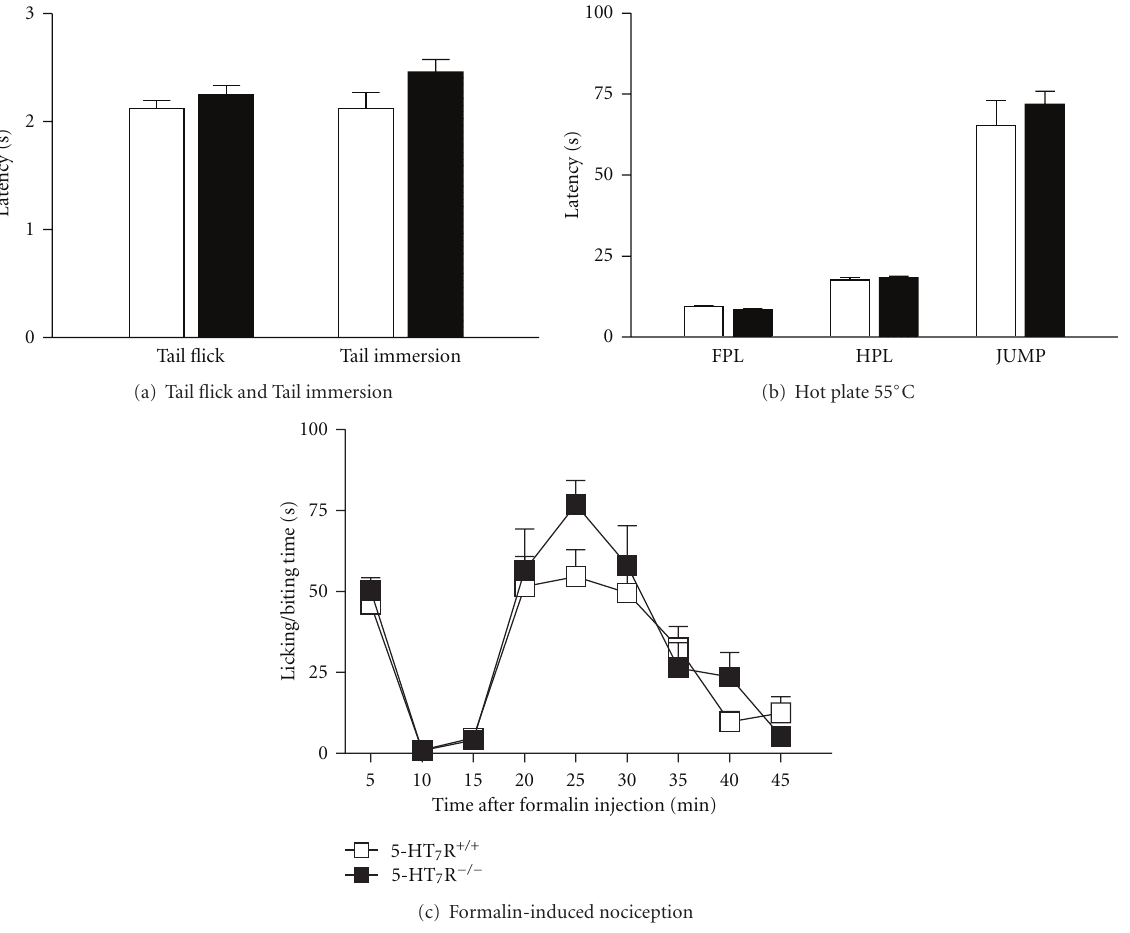
Figure 1: Nociceptive behavior of wild-type and 5-HT 7 receptor knockout mice in the tail flick and tail immersion tests (a), hot plate 55 ◦ C test (b), and formalin test (c). Both genotypes showed similar latency for all measured behaviors in the tail flick, tail immersion, and hot plate tests. Formalin-induced licking and biting of the hind paw injected with formalin in 5-HT 7 receptor knockout mice did not significantly di ff er from those in wild-type mice either in phase I (0–5 min) or in phase II (15–45 min). Only a slight but not significant increase of the licking/biting time was observed 25 min after formalin injection in 5-HT 7 receptor knockout mice compared to wild-type mice. Each bar or symbol represents the mean ± S.E.M. ( n = 10–12 per group). Forepaw licking: FPL; hindpaw licking: HPL. No significant di ff erences were observed in thermal nociception (unpaired Student’s t -test) or formalin-induced nociceptive behaviors (Two-Way ANOVA).